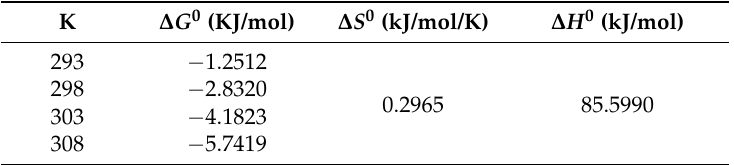
Figure 19. Plot of ln Kc vs. 1/ T for initial pH of 5, contact time of 120 min and initial concentration of 700.00 mg/L. Table 10. The thermodynamic parameters for adsorption of MG onto